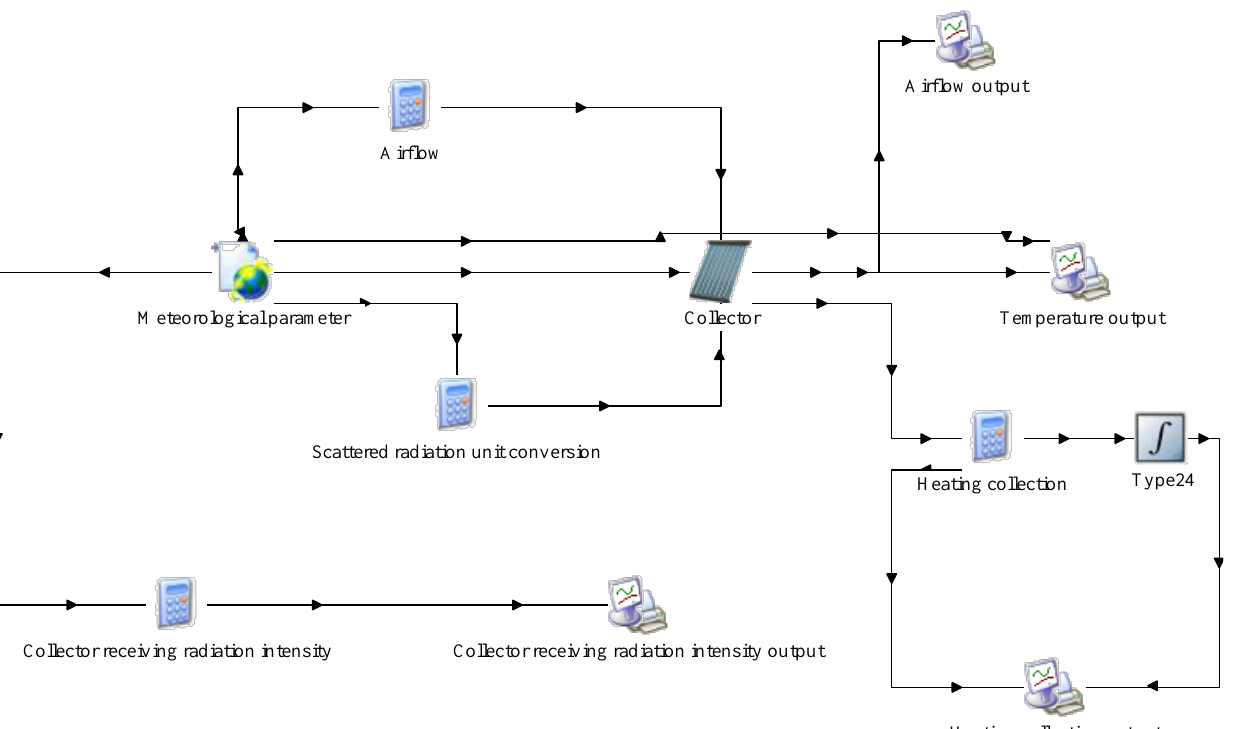
Figure 4. Solar air collector model. Table 1. Experimental instrument parameters.